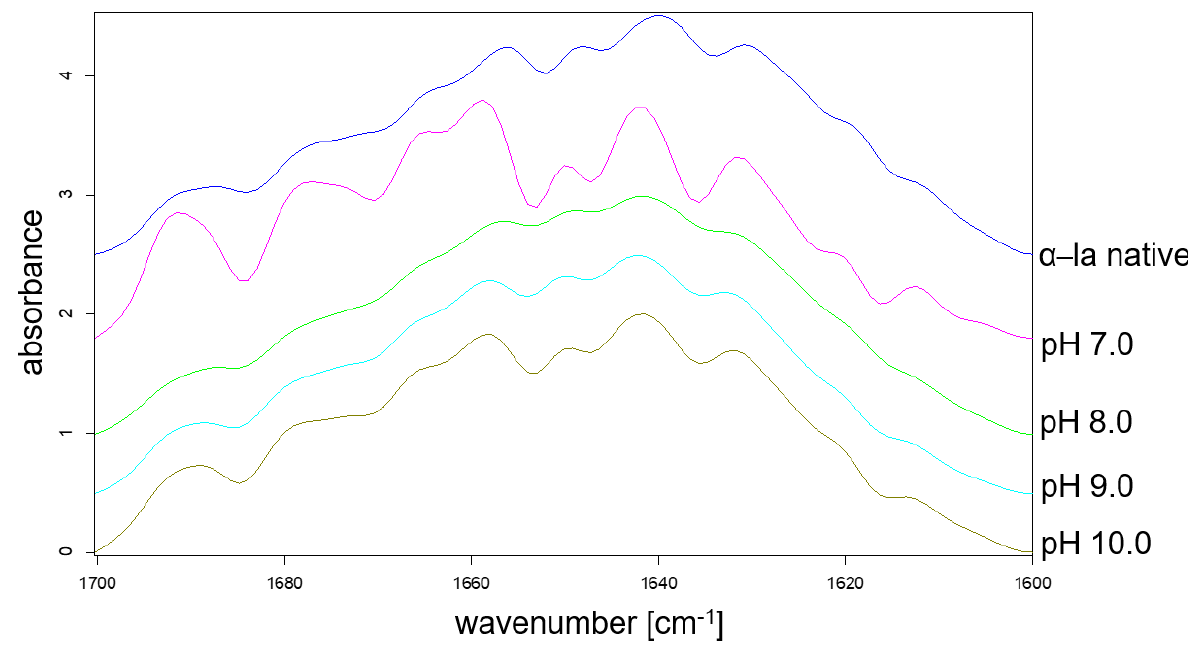
Figure 4. FTIR spectrum of the Amid I band of native α -la is compared to the batches that were resolubilized at pH values between 7.0 and 10.0.